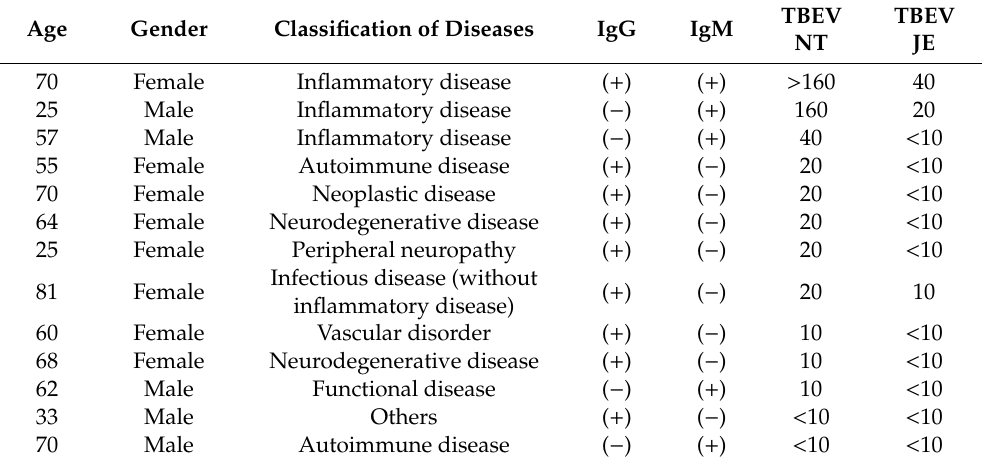
Table 3. Details of anti-TBEV antibodies in sero-positive